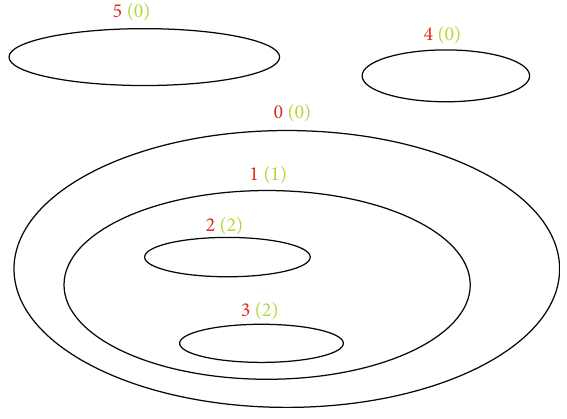
Figure 9: Schematic diagram of contour hierarchy. Table 1: Hierarchical matrix for all contours in Figure 9. Contour